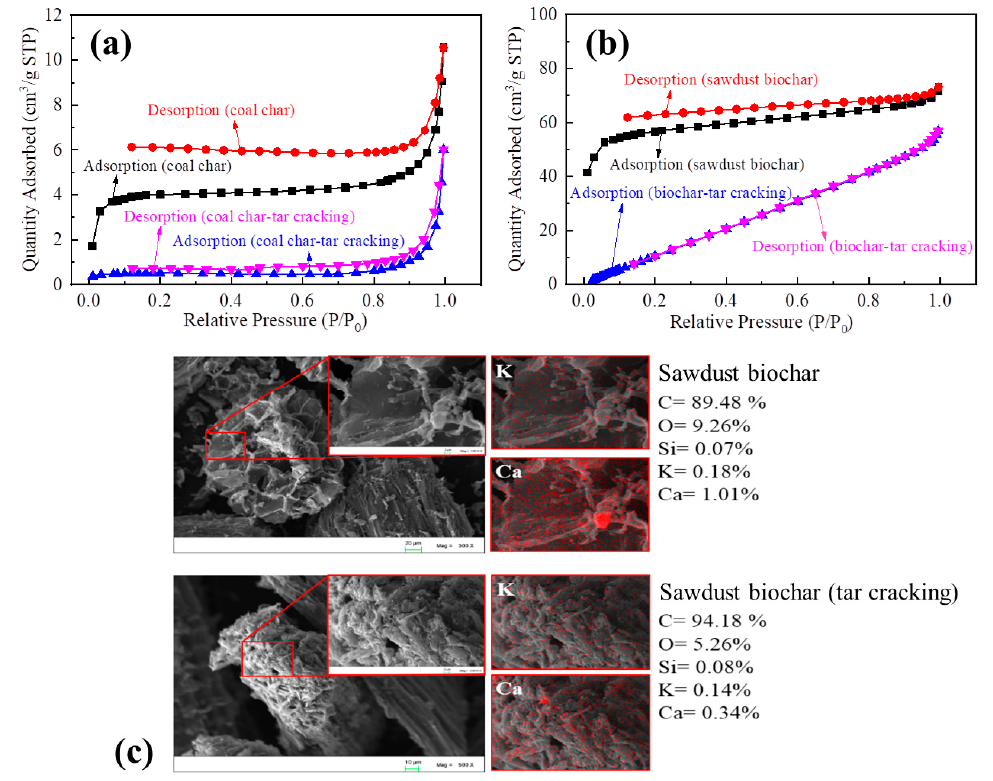
Figure 4. Physical characteristics of char-based catalysts on in-situ biomass tar reforming: Isothermal nitrogen adsorption/desorption curves of ( a ) coal char and ( b ) sawdust biochar; ( c ) SEM-EDS results of sawdust biochar.